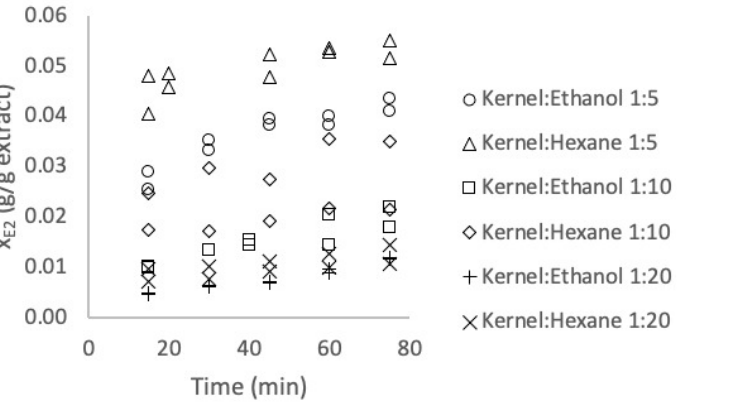
Figure 3. Extract concentrations vs. time in kernel feed extraction at 50 °C (1–4.5 mm particle size).